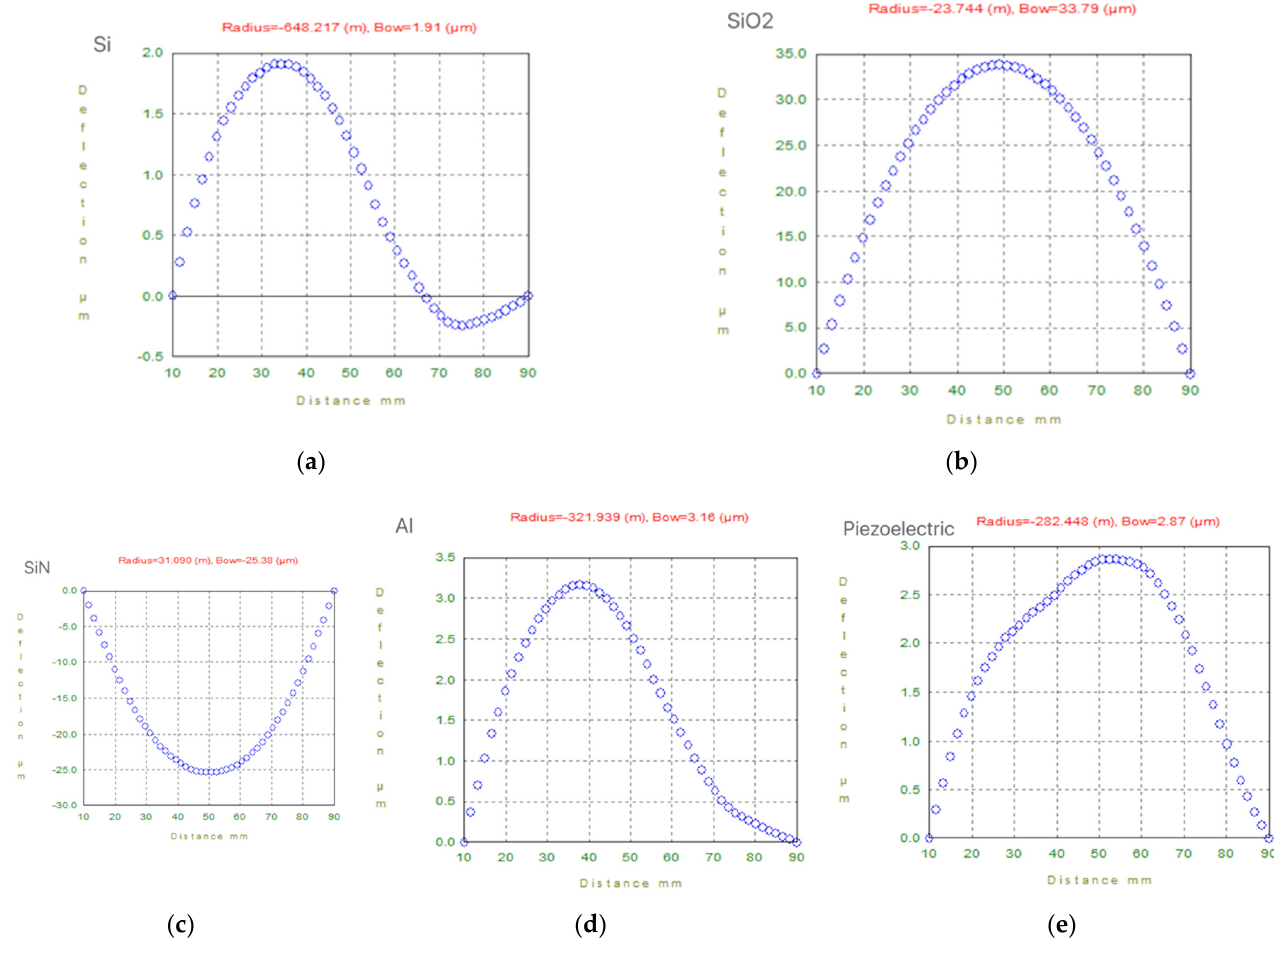
Figure 4. The test results of the radius of curvature of the film. ( a ) Si; ( b ) SiO 2 ; ( c ) SiN; ( d ) Al; ( e ) Piezoelectric.